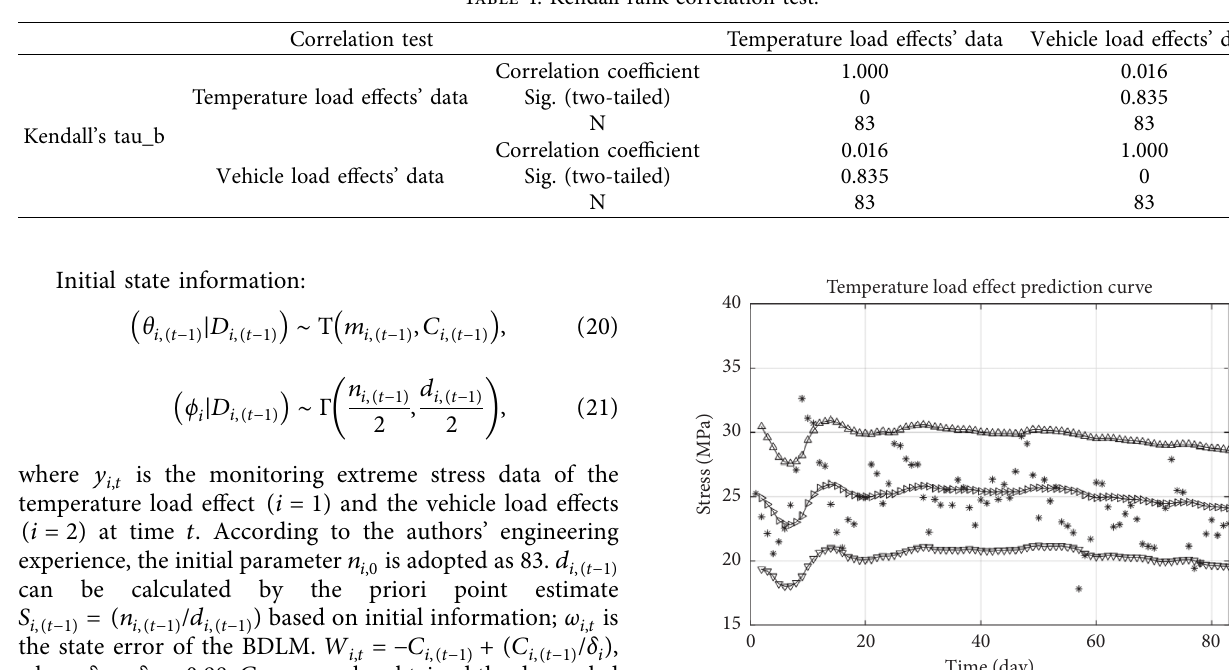
Table 4: Kendall rank correlation test.